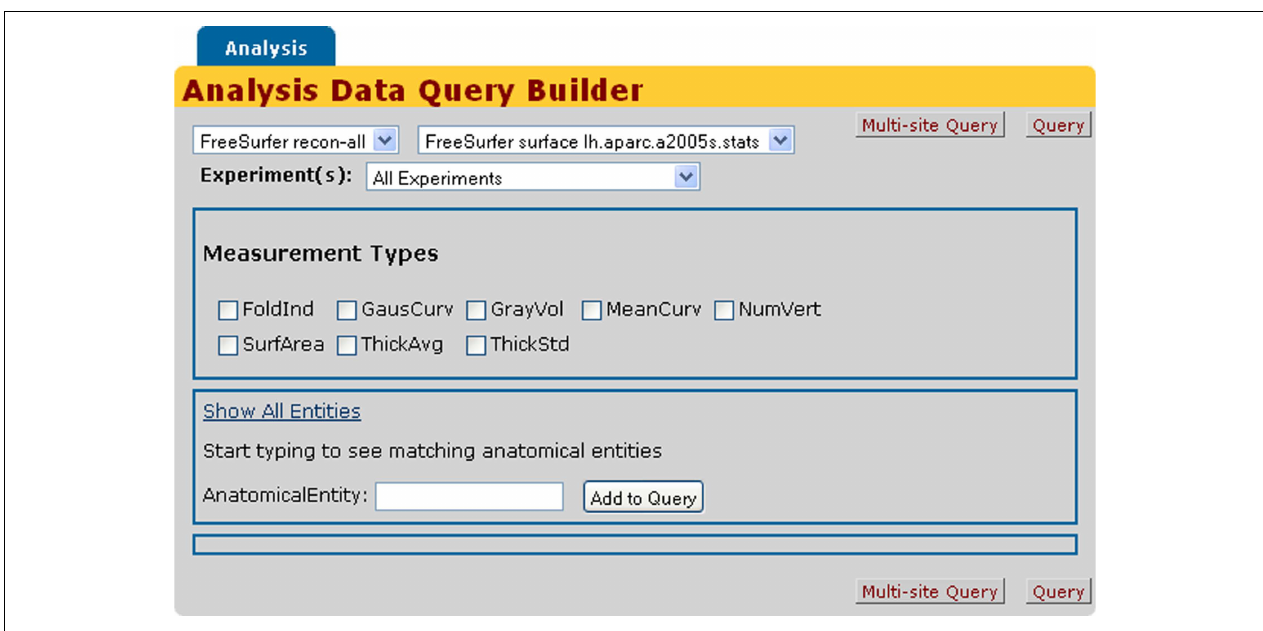
FIGURE 10 | HID web interface derived data query form for StructMorph